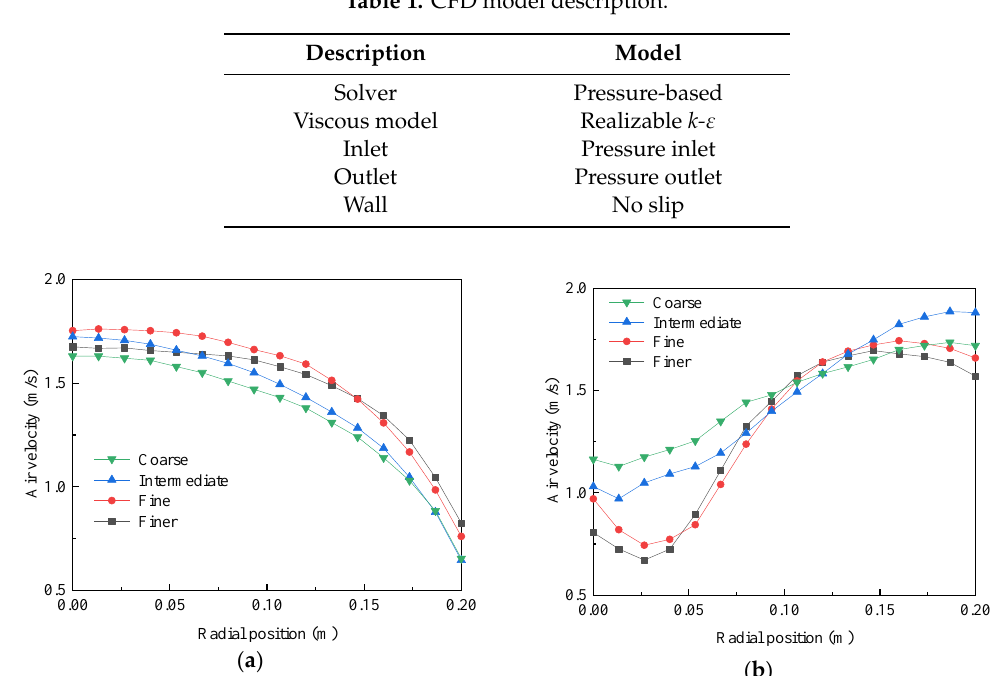
Figure 2. Quantitative comparison for different mesh sizes of ( a ) conventional hopper; ( b ) spiral hopper.